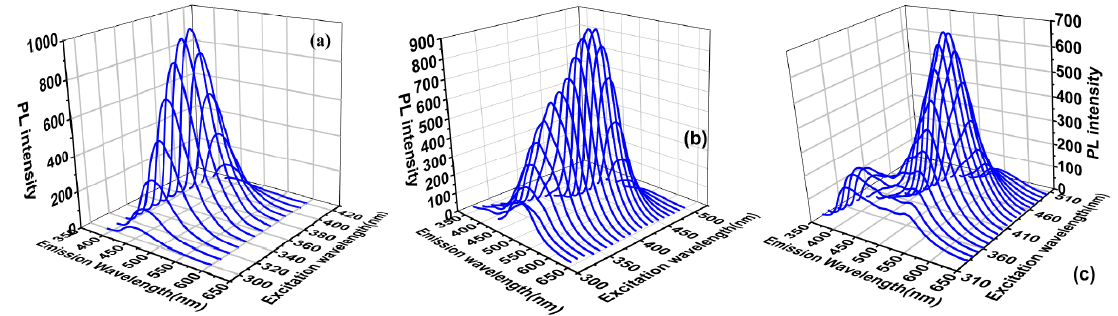
Figure 4. Three-dimensional fluorescence spectra of the three kinds of ( a ) b-SiQDs; ( b ) g-SiQDs, and ( c ) y-SiQDs.